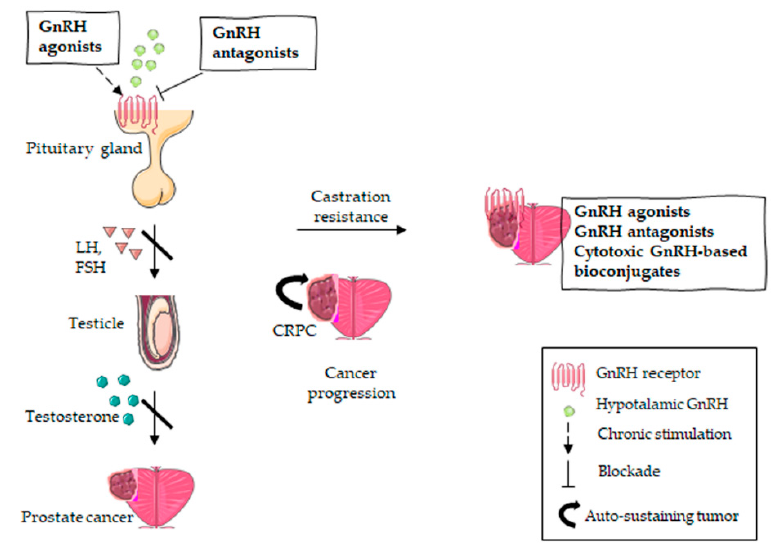
Figure 2. GnRH-R-targeted therapies in PCa treatment. Androgen-responsive PCa is targeted with GnRH antagonists (direct inhibition of the pituitary GnRH receptor) or GnRH agonists (chronic stimulation inducing receptor desensitization), resulting in the suppression of the pituitary axis. The inhibition of androgen production leads to tumor regression. However, PCa can become castration-resistant, which means tumor progression occurs despite the suppression of the pituitary axis. Given the expression of GnRH receptors on CRPC cells, the latter might be further specifically targeted with GnRH agonists, GnRH antagonists or cytotoxic GnRH-based bioconjugates.